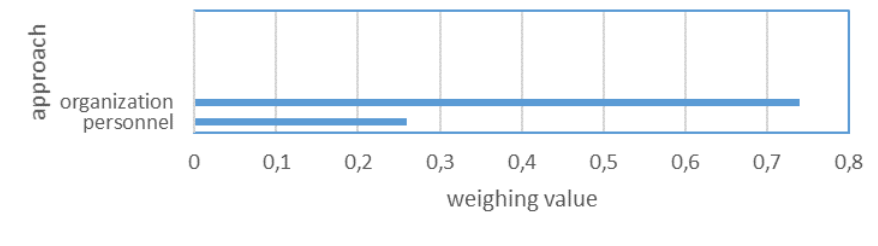
Figure 3: Result of management sub criteria weighing value (Inconsistency ratio=0.00)